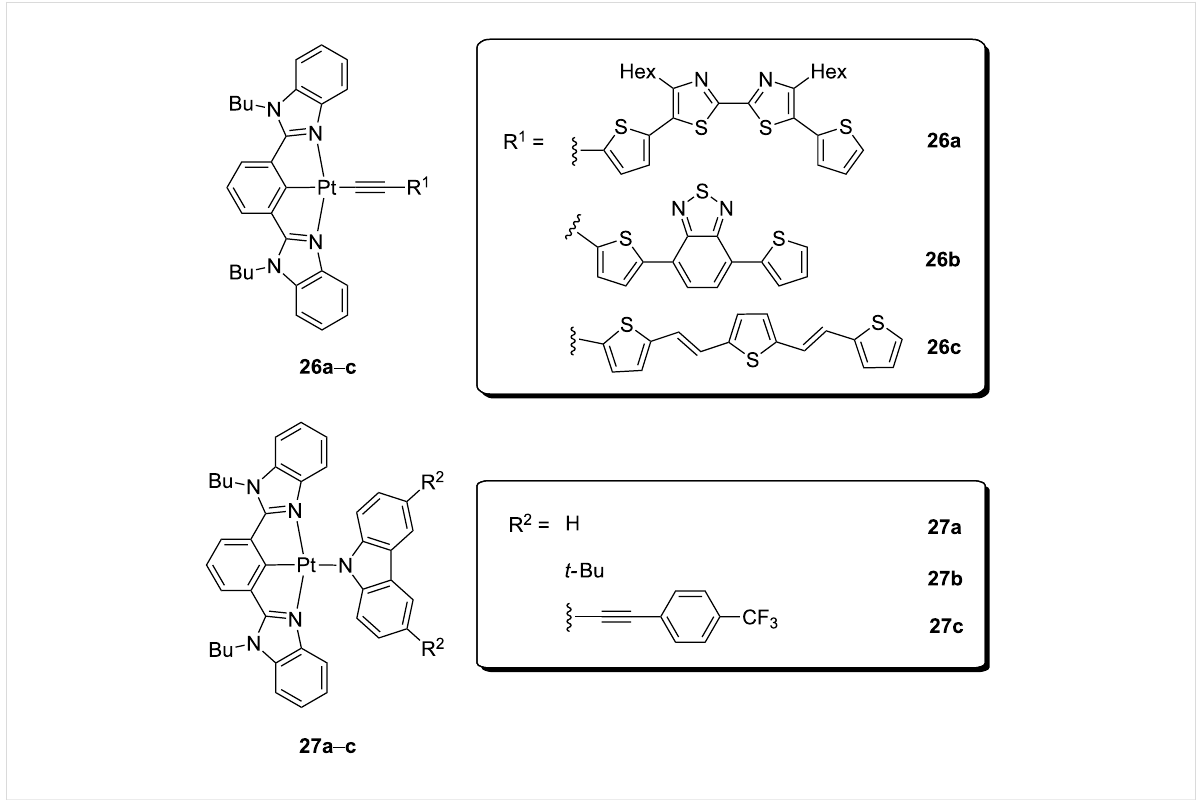
Figure 14: Molecular structures of neutral platinum(II) complexes comprising donor-acceptor alkynyls ( 26 ) or electron-rich carbazoles ( 27 ) as ancil- lary ligands